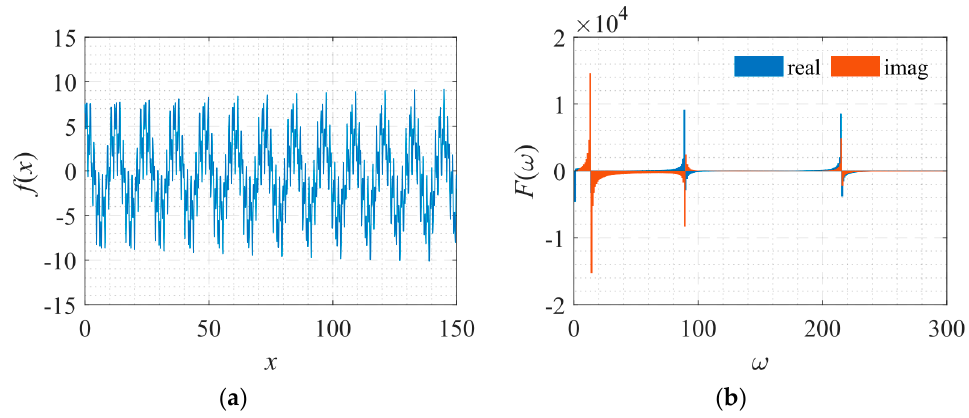
Figure 10. Signal described by Equation (11) with its frequency spectrum. ( a ) The function to be fitted. ( b ) The spectrum of the function. According to the trend of the solid red line and the red dashed line in Figure 11, it was shown that the convergence speed of the PFF-DNN method was about an order of magnitude larger. With the increase in ∆ ω , the convergence time of the PFF-DNN method only doubled. Thus, the larger ∆ ω , the more training time the PFF-DNN method saves as compared to the PhaseDNN method. Figures 12 and 13 visually show the convergence process of the two networks.